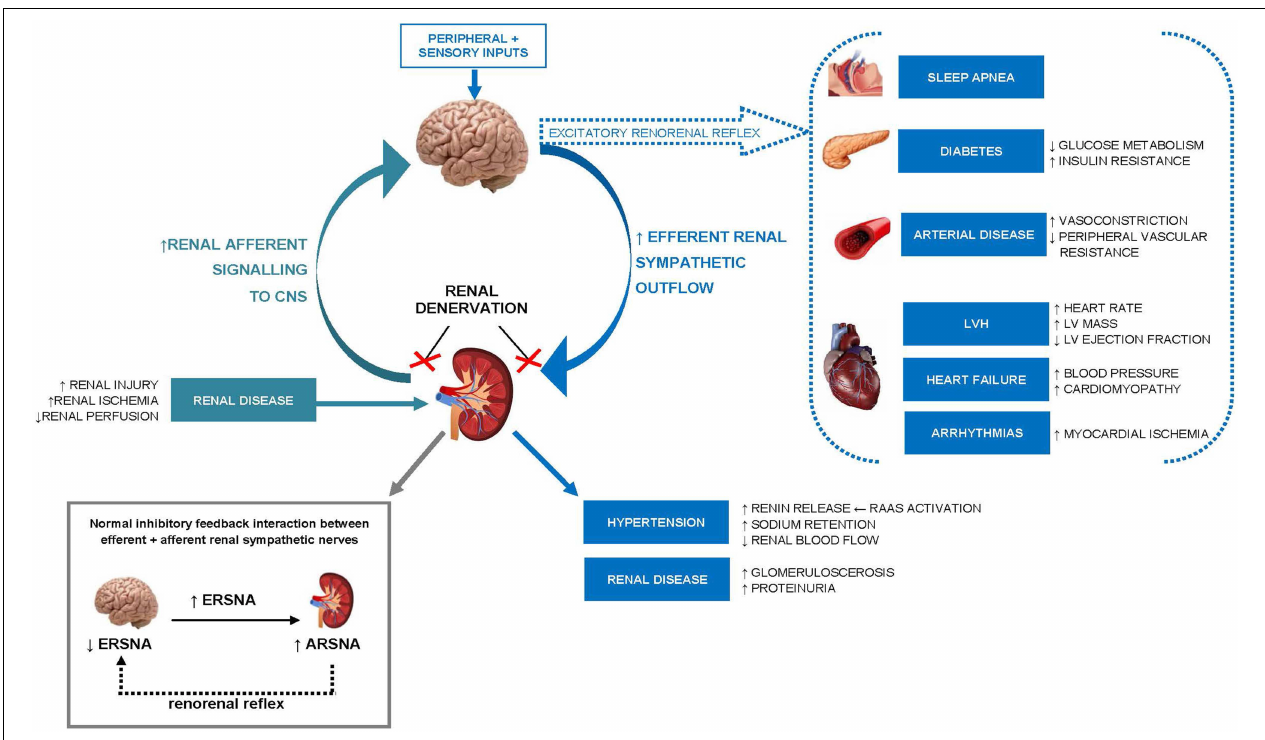
FIGURE 1 | Schematic illustration of the role of increased renal efferent sympathetic outflow and increased renal afferent sensory signaling in the pathophysiology of hypertension and other cardiovascular, renal, and metabolic disease states. ERSNA,